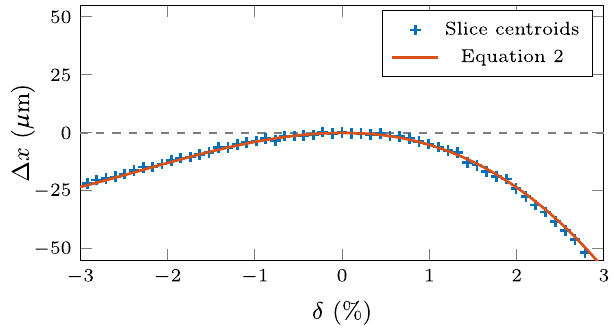
FIG. 2. Horizontal offset of the beam after the BC, as a function of δ . The blue marks show the slice centroids of the tracked beam and the red line is Eq. (2) with the corresponding coefficients for the BC in